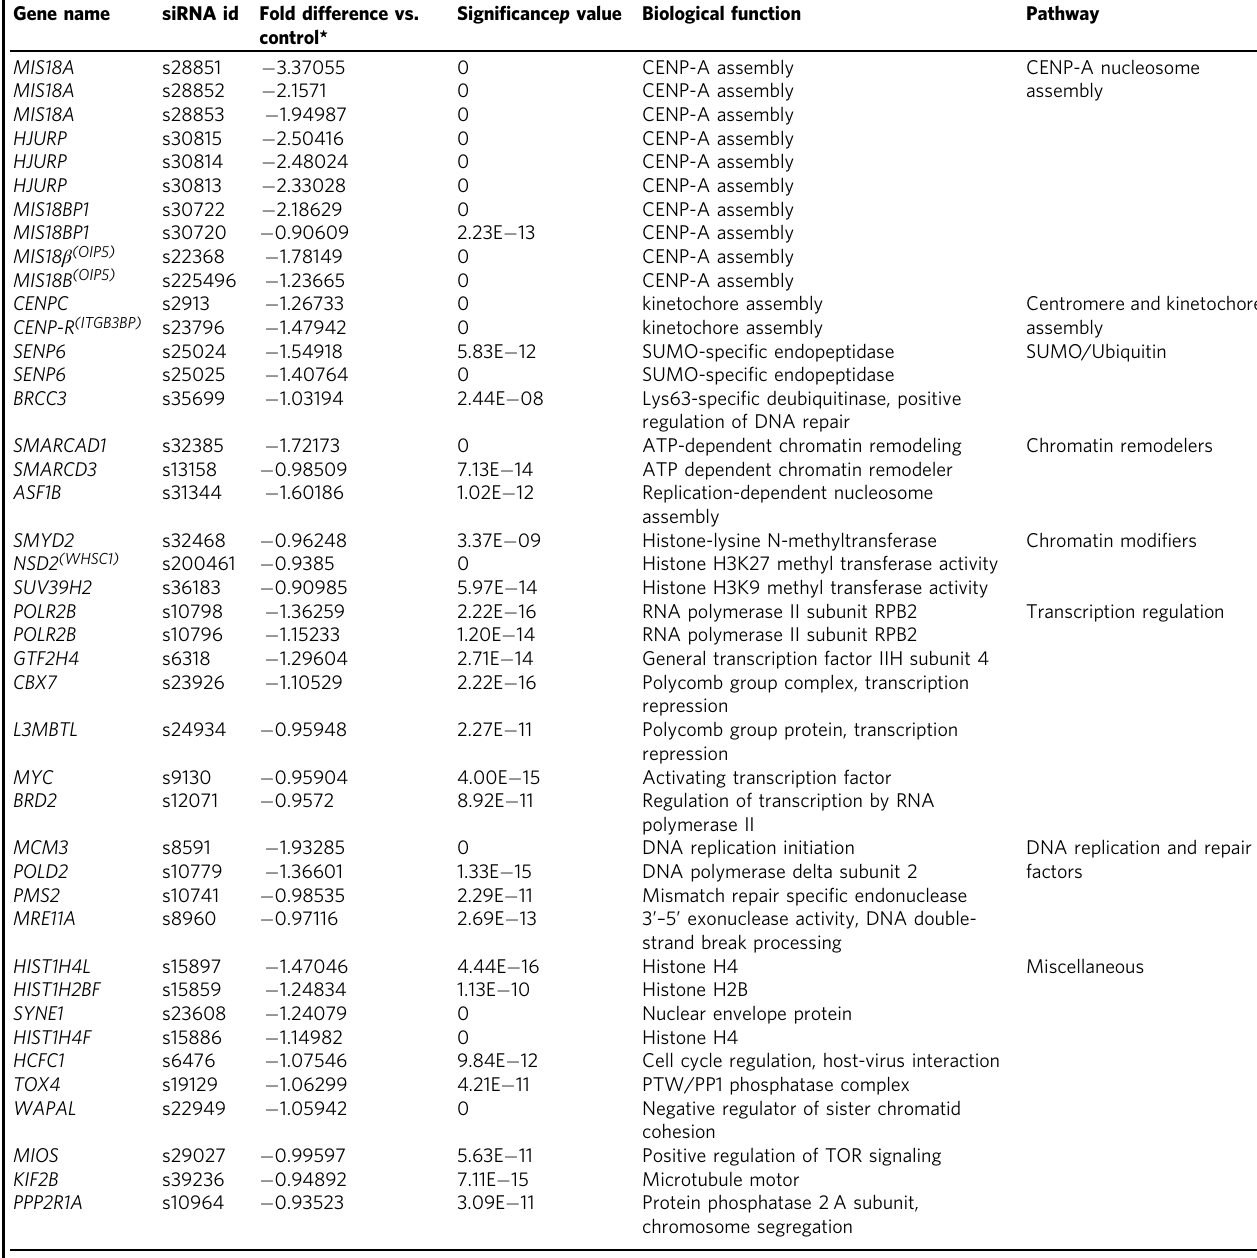
*log 2 (fold change of candidate gene vs. control) List of candidate genes affecting assembly of nascent CENP-A at centromeres, clustered in pathways. Listed are hits with a fold difference higher than 1.9 ( − 0.9 on log 2 scale) of mean ‘ new ’ CENP-A signal intensity in the siRNA treatment vs. the negative scrambled siRNA control and have a signi fi cance over